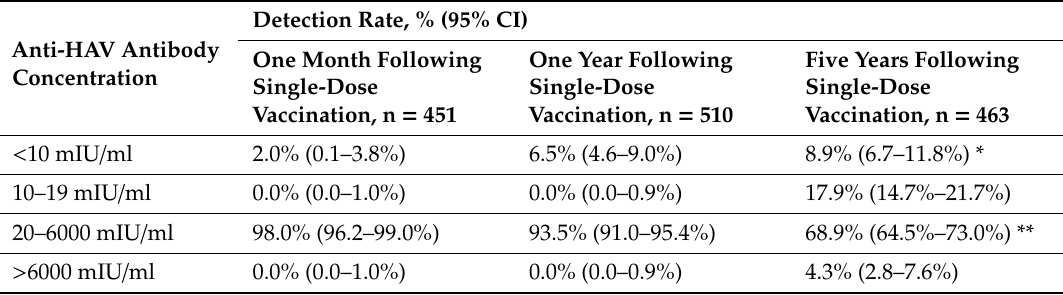
Table 3. Distribution of serum anti-HAV antibody concentrations in samples from vaccinated children collected one month, one year, and five years following single-dose vaccination.